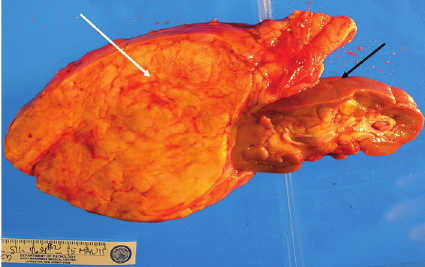
Figure 3: Gross image of the en bloc resected mass including the left kidney (black arrow), demonstrating a well-encapsulated fatty mass attached to the upper pole of the kidney (white arrow) with a smooth outer surface measuring 23 cm × 14cm ×